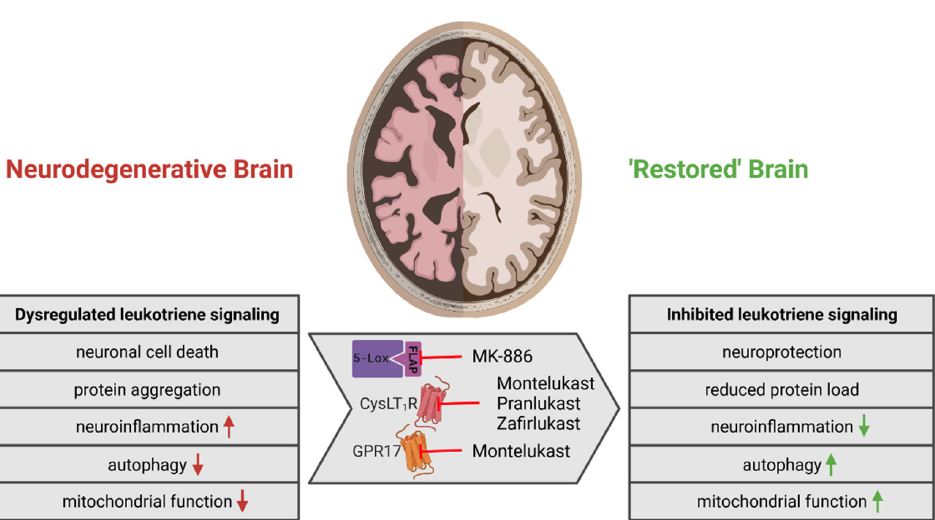
Figure 4. Overview of the effects of leukotrienes and leukotriene inhibition on the neurodegenerative brain. The interference of leukotrienes with various aspects and processes of brain homeostasis contributes to the development of neurodegenerative diseases. Several in vitro and in vivo studies have shown that the inhibition of leukotriene signaling at the level of 5-lipoxygenase by MK-886 or at receptor level using the cysteinyl-leukotriene receptor antagonists Montelukast, Pranlukast or Zafirlukast can ameliorate these impairments and lead to restored brain function. Upward arrows indicate an increase and downward arrows indicate a decrease. Created with BioRender.com (last accessed on 4 November